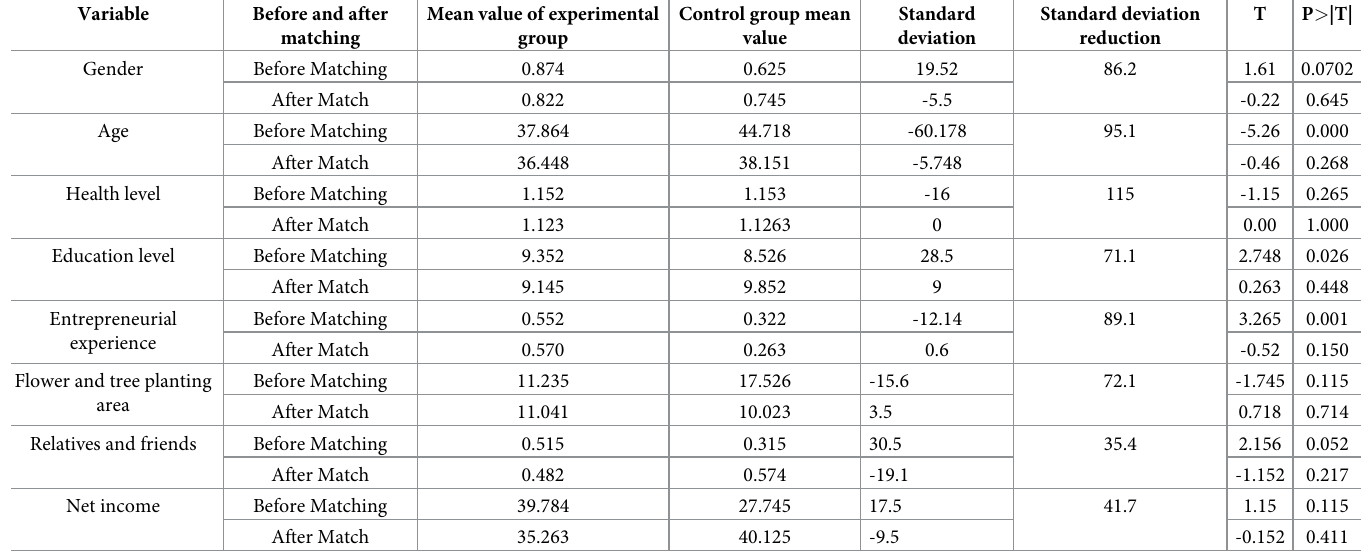
Table 6. The standard deviation of the mean values of variables before and after